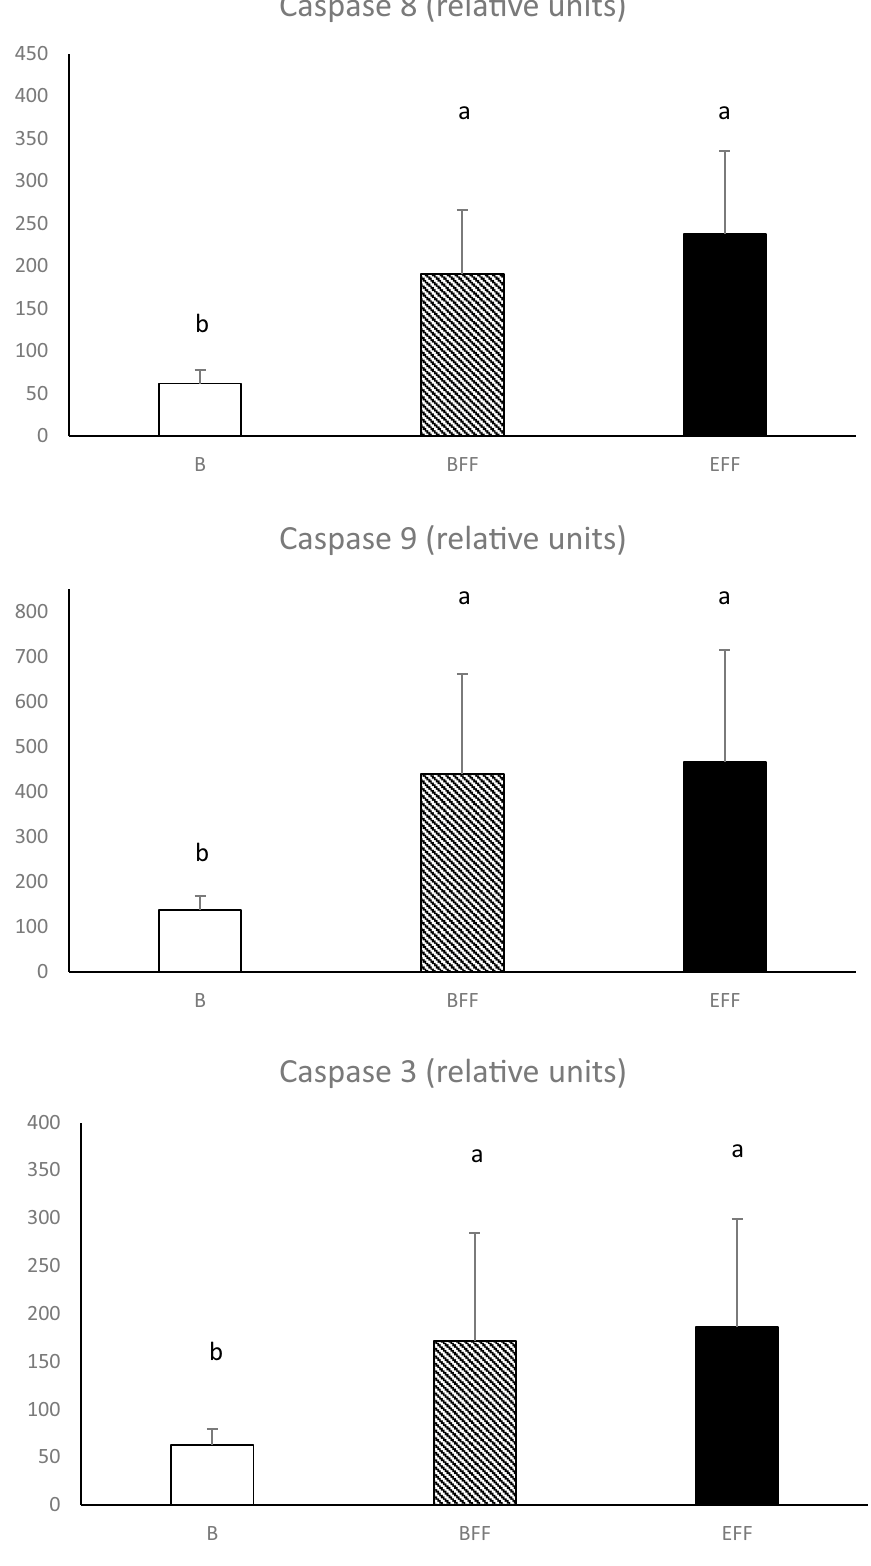
Figure 4. Caspase-3, caspase-8 and caspase-9 relative activities in livers collected before (B) or at the beginning (BFF) or at the end (EFF) of the force-feeding period. Values are means ± SD. Bars with different letters differ (p <